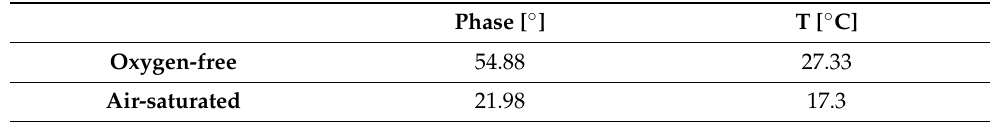
Table 2. Calibration values of phase for oxygen-free and air-saturated